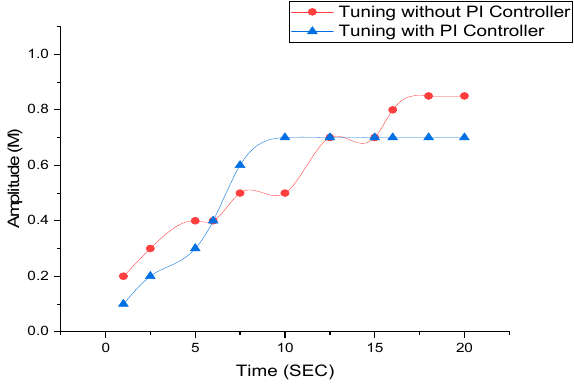
Figure 8. Tuning with and without PI controller using hybrid MOSOS-SA.